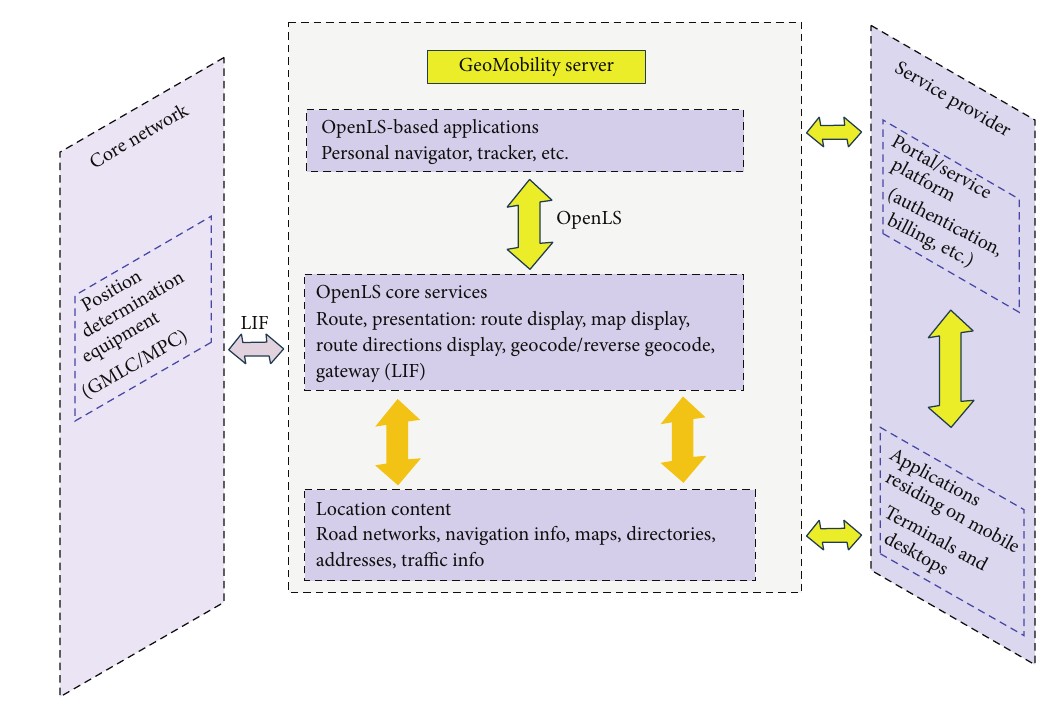
Figure 9: GeoMobility